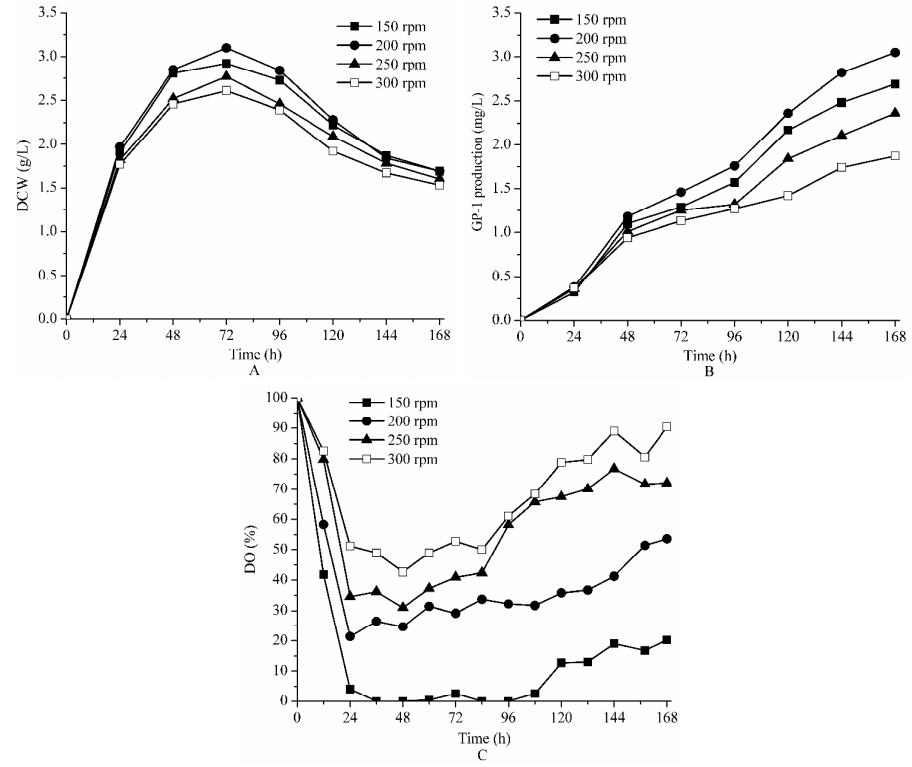
Figure 2. The effect of agitation speed on DCW ( A ); GP-1 production ( B ) and DO ( C ) during batch fermentation of Streptomyces kanasenisi ZX01 in 5 L fermentor.